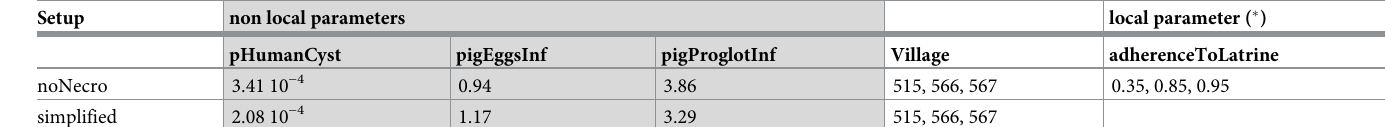
Table 8. Parameter from the best fit runs. Setup non local parameters local parameter ( � ) noNecro simplified Parameter from the best fitting run of noNecro and simplified calibration setups. Non-local parameters take the same values for all the villages and the local parameter is included only for the noNecro calibration